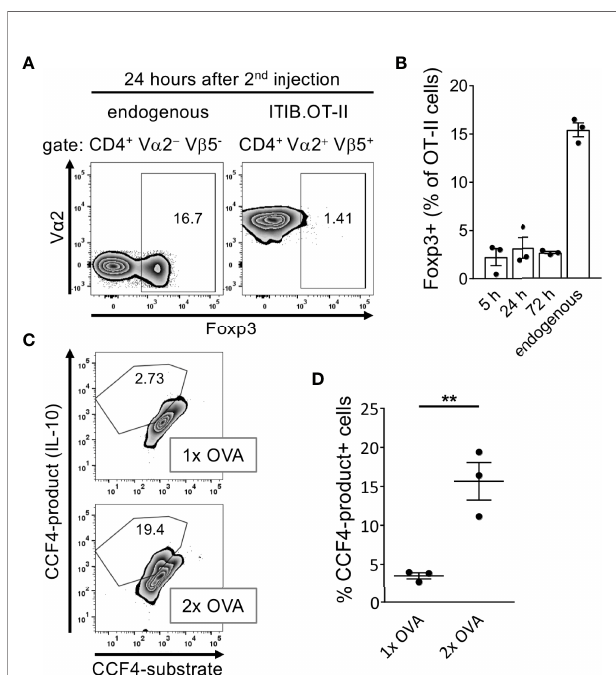
FIGURE 4 | Anergic T cells acquire a Foxp3 − IL-10+ Tr1-like phenotype after the second OVA injection. Splenocytes were isolated at indicated time points after the fi rst or second OVA protein injection. (A) Representative fl ow cytometry plots at 24 hours after the second OVA injection show the frequency of Foxp3 + cells within the endogenous CD4 + or the transferred ITIB.OT-II.Rag1 -/- population. (B) Frequency of Foxp3 + cells within the ITIB.OT-II population at different time points. Dots represent individual mice. The frequencies of Foxp3 + cells within the endogenous CD4 + populations were obtained at 24 hours after injection but are representative for all time points. (C) Splenocytes were tested for IL-10 production by b -Lactamase reporter activity after restimulation with PMA/Ionomycin for 4 hours. Representative fl ow cytometry plots show the frequency of CCF4 + cells within the ITIB.OT-II population 24 hours after the fi rst (upper plot) or second OVA injection (lower plot). (D) Frequency of CCF4-product + cells within the ITIB.OT-II population after the fi rst or second OVA injection. Dots represent 3 mice per group. Dots represent individual mice. All data is shown as mean ± SEM, **p < 0.01, unpaired